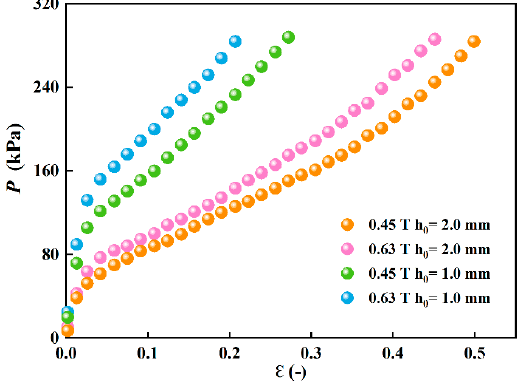
Figure 5. Comparison for the value of compressive stresses between two different initial gap distances ( h 0 = 1 mm and h 0 = 2 mm) under two magnetic fields.